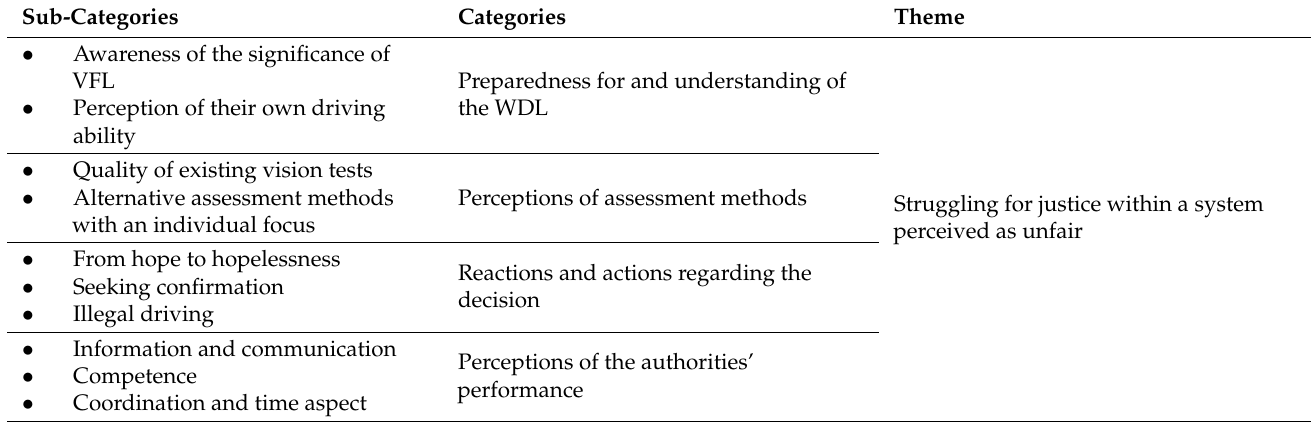
Table 3. Sub-categories, categories, and